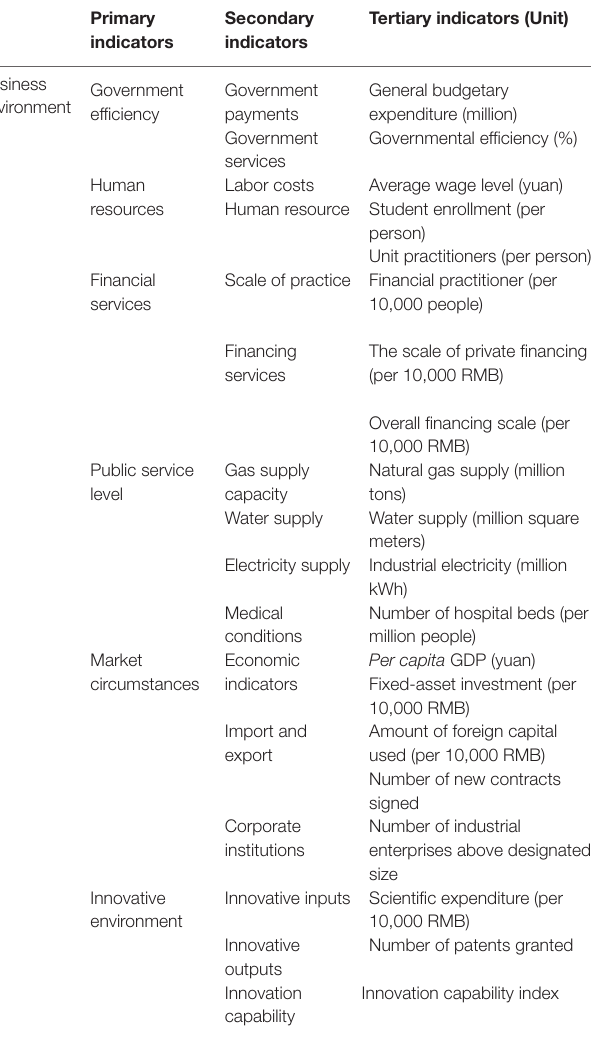
TABLE 1 | Business environment indicator